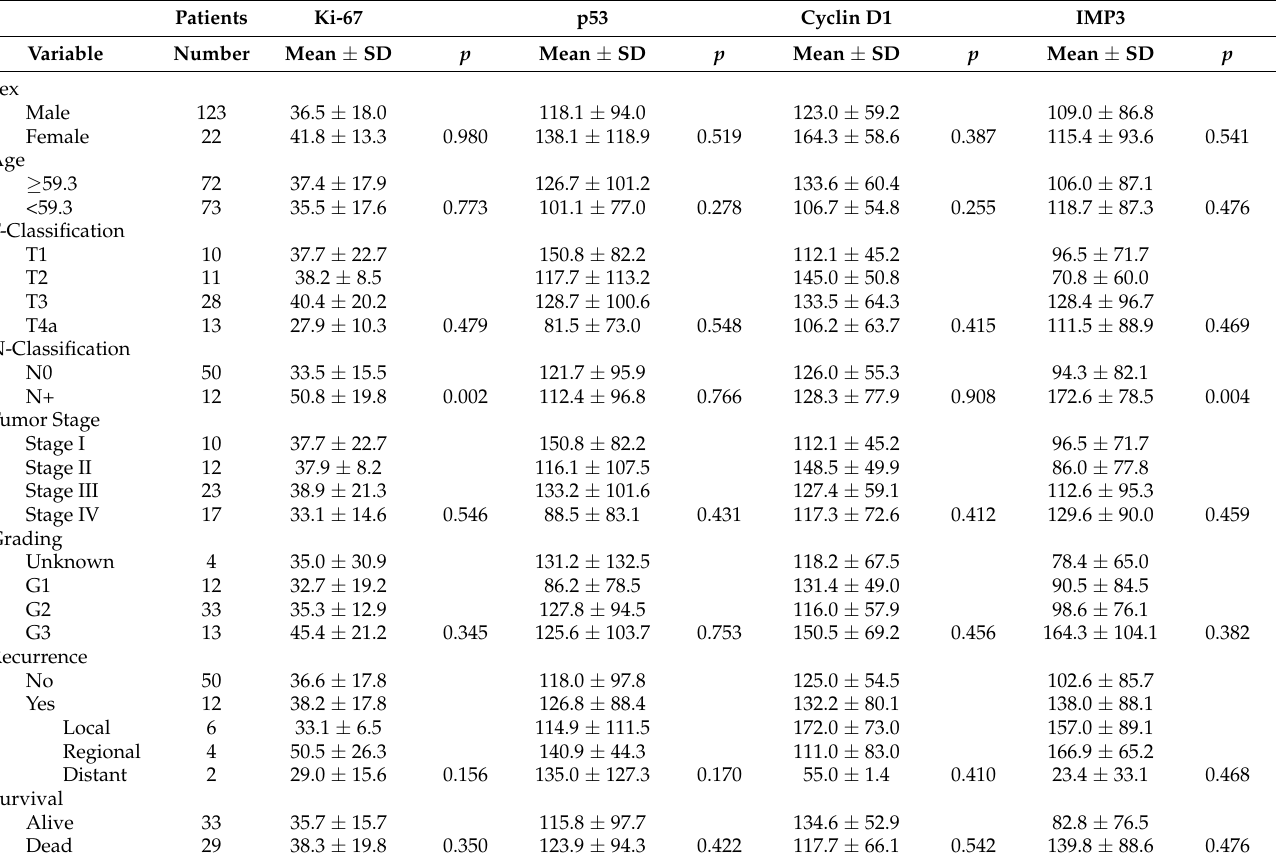
Table 4. Correlation of Ki-67, p53, cyclin D1, and IMP3 markers with clinicopathologic features of the examined